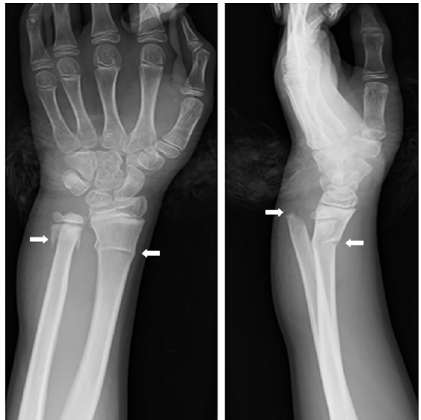
Image 1. Anteroposterior (left) and lateral (right) radiographs of the distal forearm and wrist joint. Radiographs show the radius and ulnar fractures